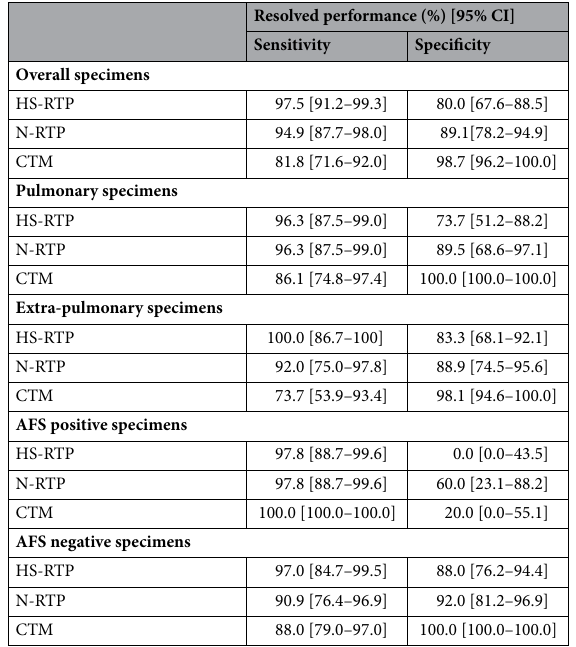
Table 4. Performance summary of HS-RTP, N-RTP, and CTM under various conditions, including on pulmonary specimens, on extrapulmonary specimens and on AFS-negative specimens. 95% CI: 95% confidence